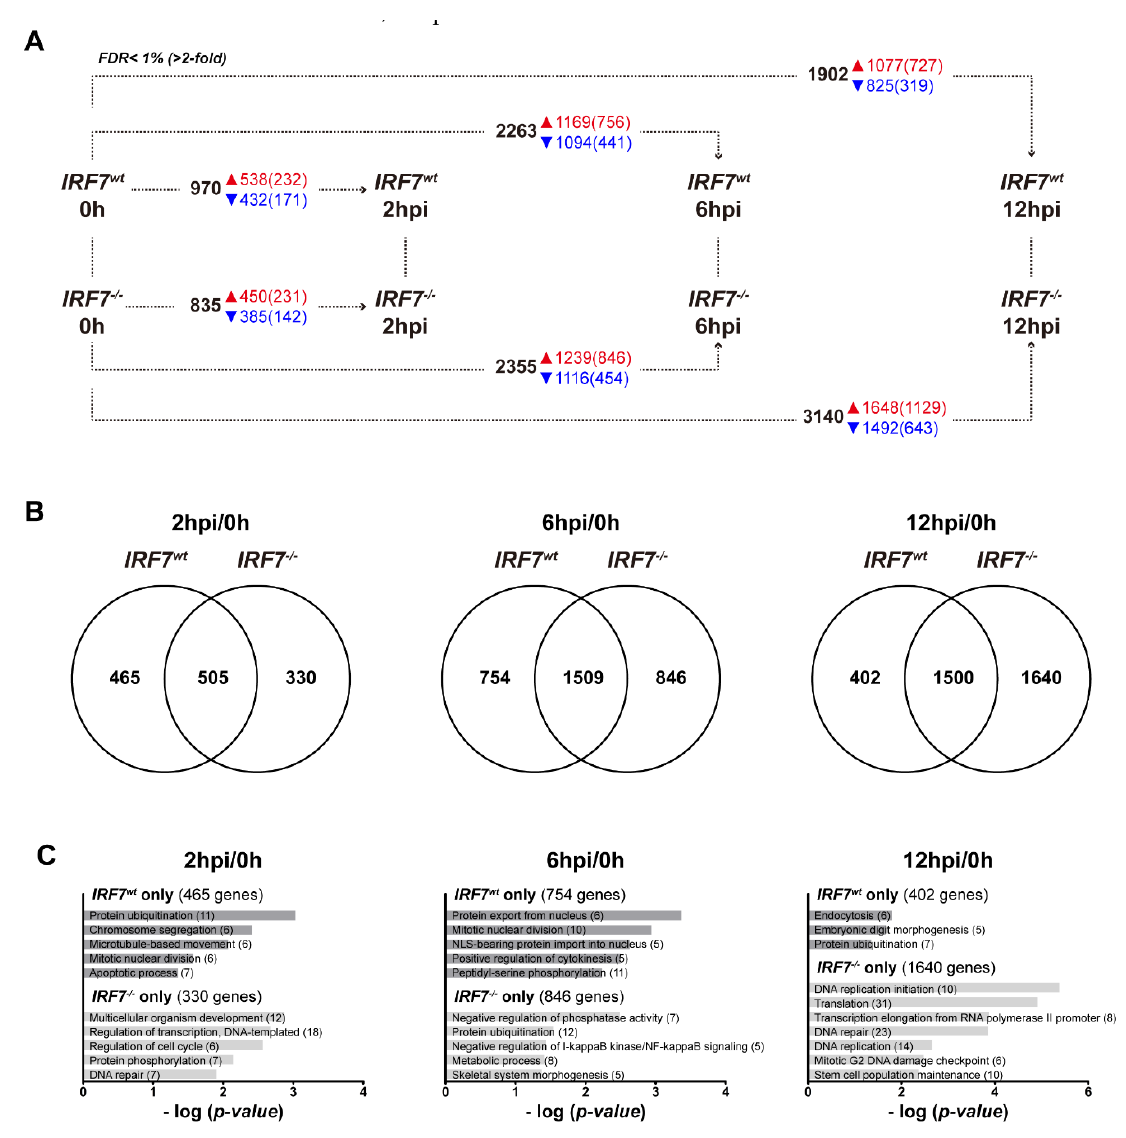
Figure 4. IRF7 deletion altered the host response against H6N2 infection ( A ) The number of differentially expressed genes (DEGs; FDR < 1%) for IRF7 wt and IRF7 -/- cell lines upon H6N2 infection at 2, 6 and 12 h post infections (hpi). Each horizontal comparison indicates the number of DEGs upon H6N2 infection at each time point compared to mock infection (0 h). The numbers of genes that have 2-fold expression changes are in the parentheses. ( B ) A Venn diagram of DEGs between IRF7 wt and IRF7 - / - cells upon H6N2 infection at each time point. ( C ) Gene ontology functional analysis was performed using each cell-specific DEG. The numbers of genes enriched in each biological process are in parentheses.